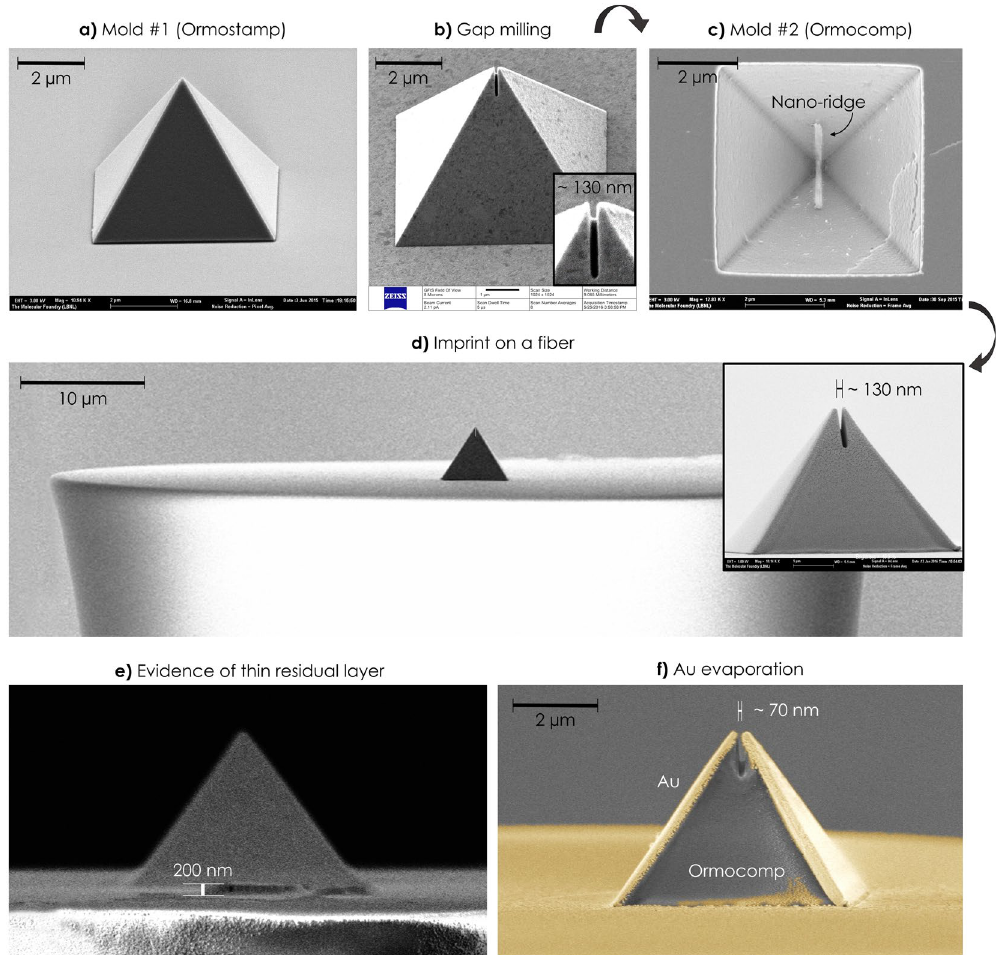
Figure 3. Micrograph of the fabrication steps. ( a ) Tilted SEM view of mold #1 (~75°) showing polymeric pyramid on a hard substrate replicated from the silicon mastermold. ( b ) Gap milling on mold #1 using Ga + - beam (tilted HIM view in Zeiss ORION NanoFab microscope, 54°). ( c ) SEM top view of mold #2, which is a replica of mold #1 in Ormocomp on a transparent support to allow imprint on the fiber. ( d ) Tilted-view (~90°) SEM of the final pyramid imprinted on an optical fiber. The inset shows a close-up of the campanile on the fiber that has a gap of about 130 nm in width at the apex. A negligible amount of superficial roughness is visible and is caused by sputtered Au-Pd added for imaging purposes. ( e ) Same view as d (but rotated 90°) that shows a residual layer of about 200 nm. ( f ) False-color SEM image of the completed campanile probe after side- evaporation of Au. The evaporated metal reduces the width of the imprinted slit, yielding a gap of about 70